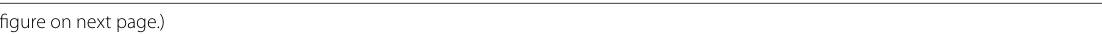
desHMGB1(See figure on next Fig. 2 Screening of monoclonal antibodies that recognize desHMGB1 but do not recognize intact HMGB1. A The cleavage site of HMGB1, located between amino acid residues R10 and G11, as well as the amino acid sequence of the P-peptide beginning from G11 of HMGB1 and the N-peptide beginning from K7 of HMGB1, are shown. B , C Of the 3800 hybridoma populations, 95 populations had supernatants that were highly reactive to the desHMGB1 peptide conjugate and underwent the second screening. Microtiter plates were coated with P- or N-peptide and incubated with the supernatants of each hybridoma population ( B ). Alternatively, polystyrene microtiter plates were coated with the capture antibody in the HMGB1 ELISA, incubated with P- or N-peptide, and then incubated with the supernatants of each hybridoma population ( C ). After washing, the plates were incubated with anti-mouse IgG peroxidase-conjugated antibodies, washed again, and incubated with the chromogenic substrate. The optical density (OD) of each well was analyzed and is shown as a heat map. In this screening test, three hybridoma populations (#47, #69, and #86) were specifically reactive to P-peptide but unreactive to N-peptide. D , E These three hybridoma populations were then each distributed into 95 wells, and the same screening procedure was again conducted to obtain a single hybridoma clone. The results of the antigen (P- or N-peptide)-coated ELISA and the antibody-coated ELISA are shown in D and E , respectively. F The results of the antibody-coated ELISA with different concentrations of desHMGB1 and different types of detection antibody (47A–C, 69A–C, 86 A–C) are shown. G We selected the hybridoma clone 47C1, which produced antibodies that specifically recognized